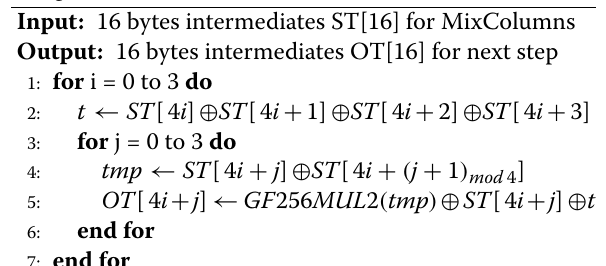
Algorithm 2 Improved computation of one MixColumns using GF256MUL